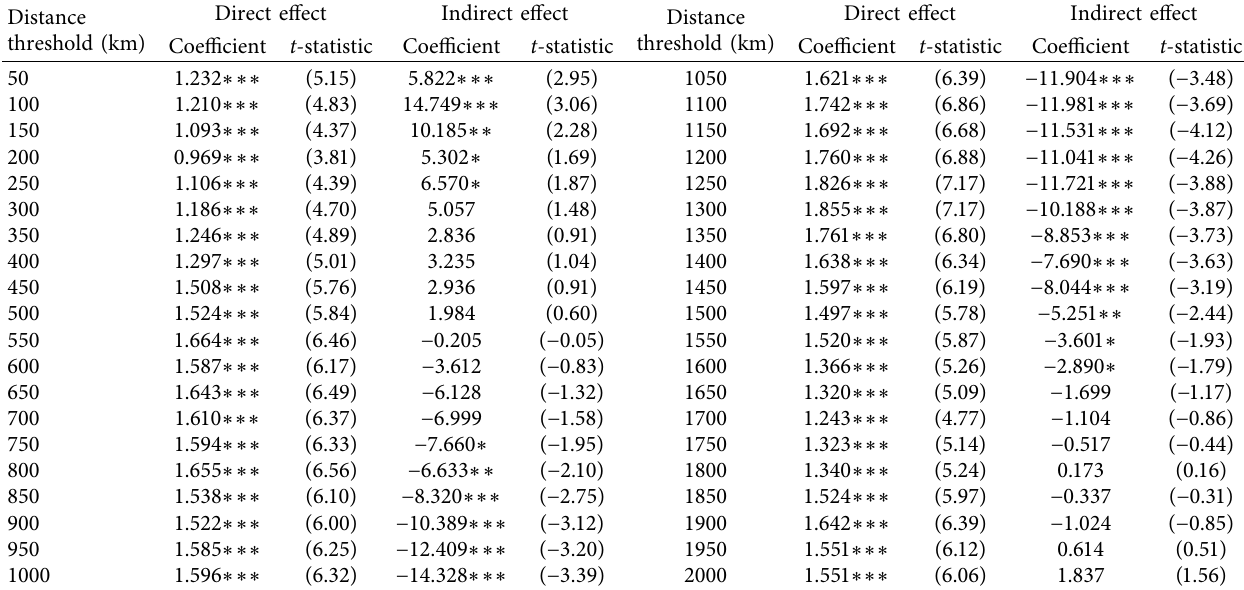
Table 12: Spatial spillover distance of the impact of the central and western regions’ digital economy on urban